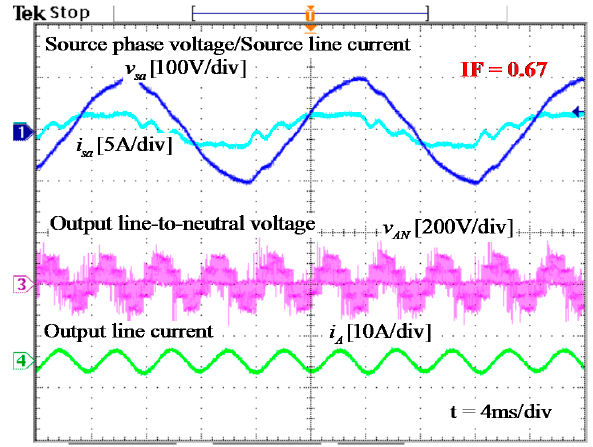
Figure 13. Source phase voltage / source current, output line-to-neutral voltage, and output line current at f o = 250 Hz ( Q = 0.54 > 0.375 ) , q = 0.7 with no